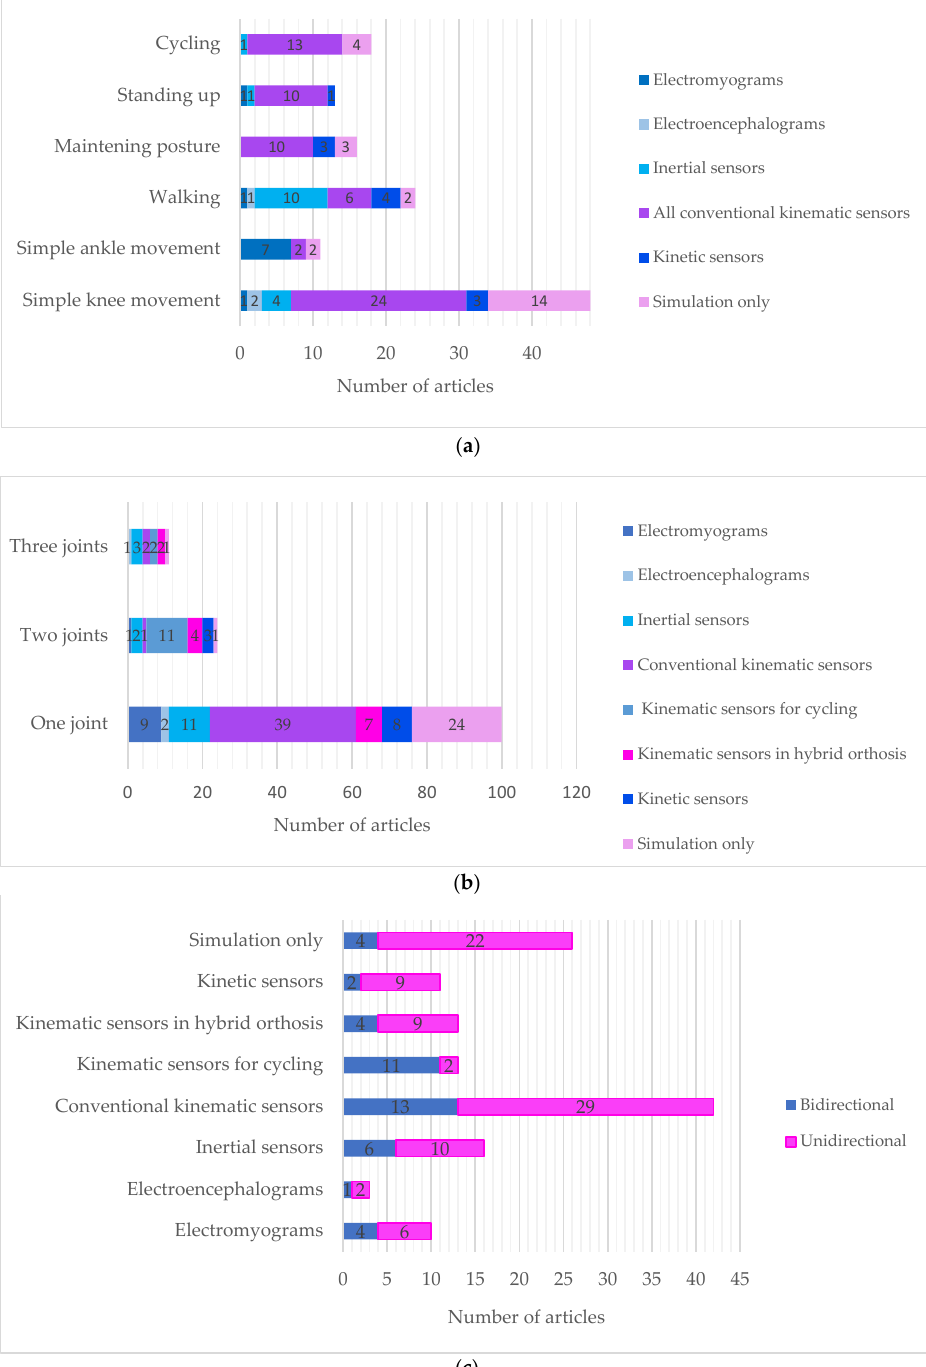
Figure 6. Type of sensors used in the studies according to: ( a ) The type of movement; ( b ) The system complexity; ( c ) The directionality induced by FES.